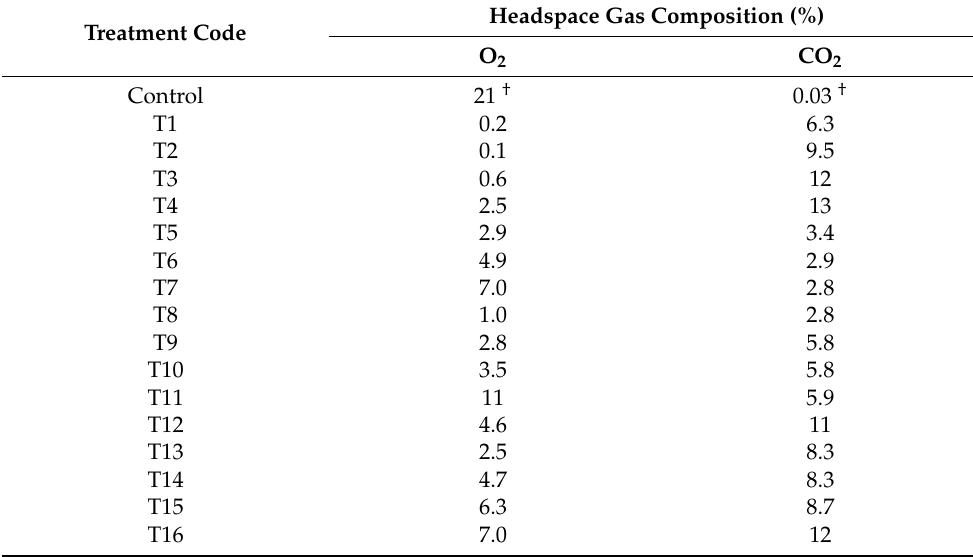
Table 1. The initial flushed gas compositions of CO 2 and O 2 for modified atmosphere packaging at an ambient temperature with a RH of 60 ± 2% 1